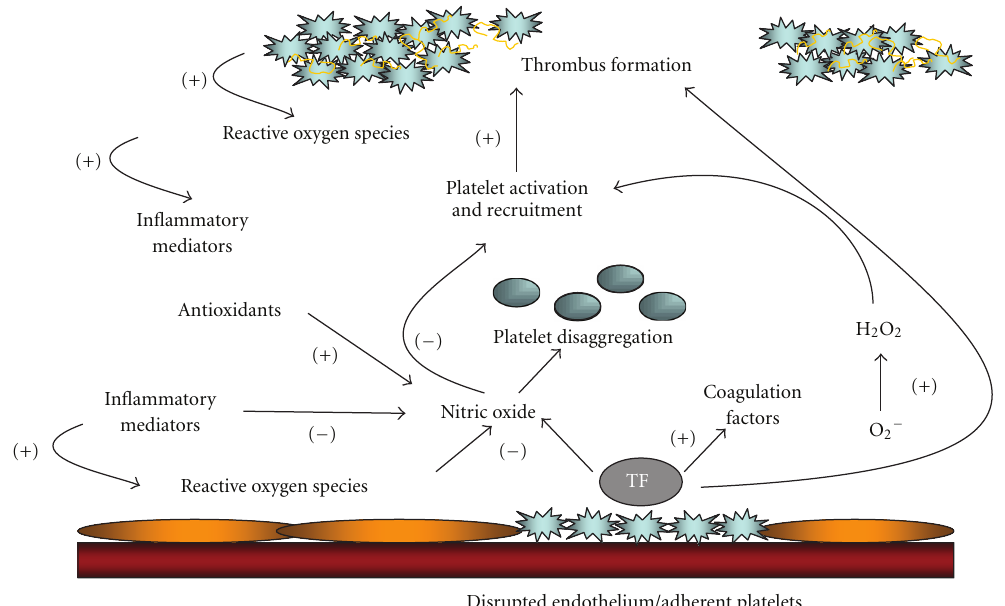
Figure 4: Oxidative stress mediates abnormal platelet function and dysfunctional endothelium-dependent vasodilation. Oxidative stress is an important mediator of both abnormal platelet function and dysfunctional endothelium-dependent vasodilation in the setting of cardiovascular disease. Superoxide anion is an important source of oxidative stress, has direct e ff ects, and limits the biological activity